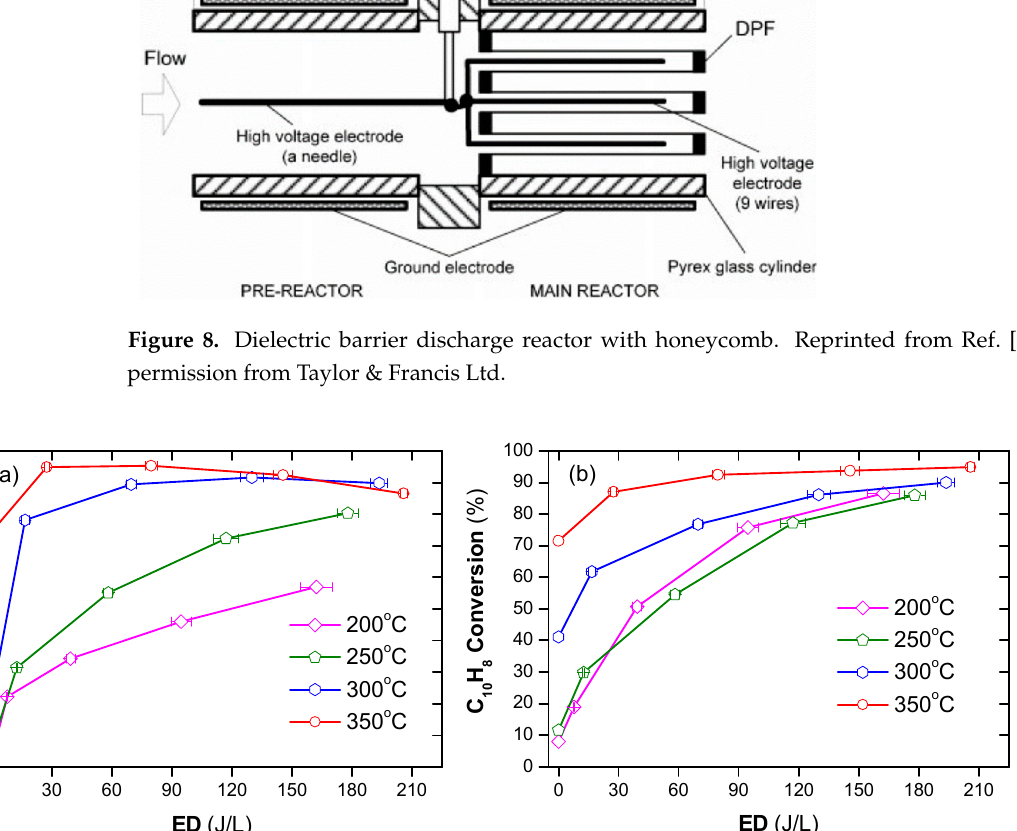
Figure 8. Dielectric barrier discharge reactor with honeycomb. Reprinted from Reference [86], with permission from Taylor & Francis Ltd.